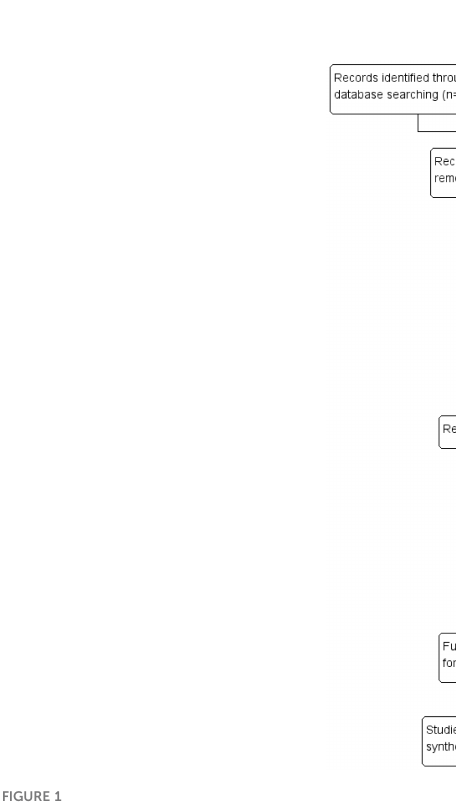
FIGURE 1 PRISMA fl ow diagram of selection